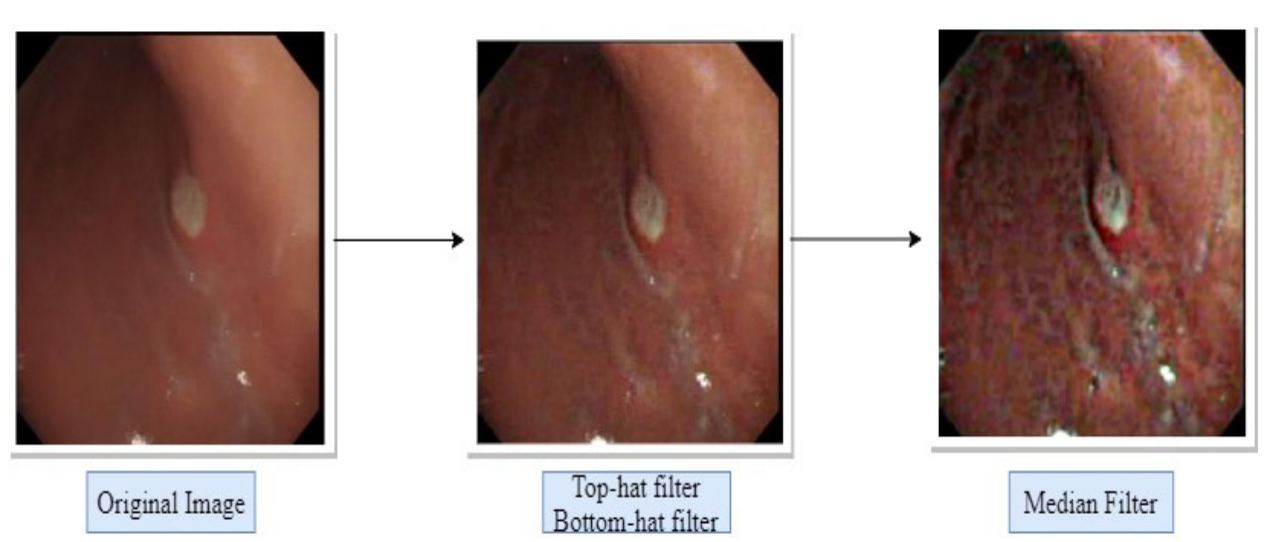
Figure 3. The results of preprocessing after the use of filters.